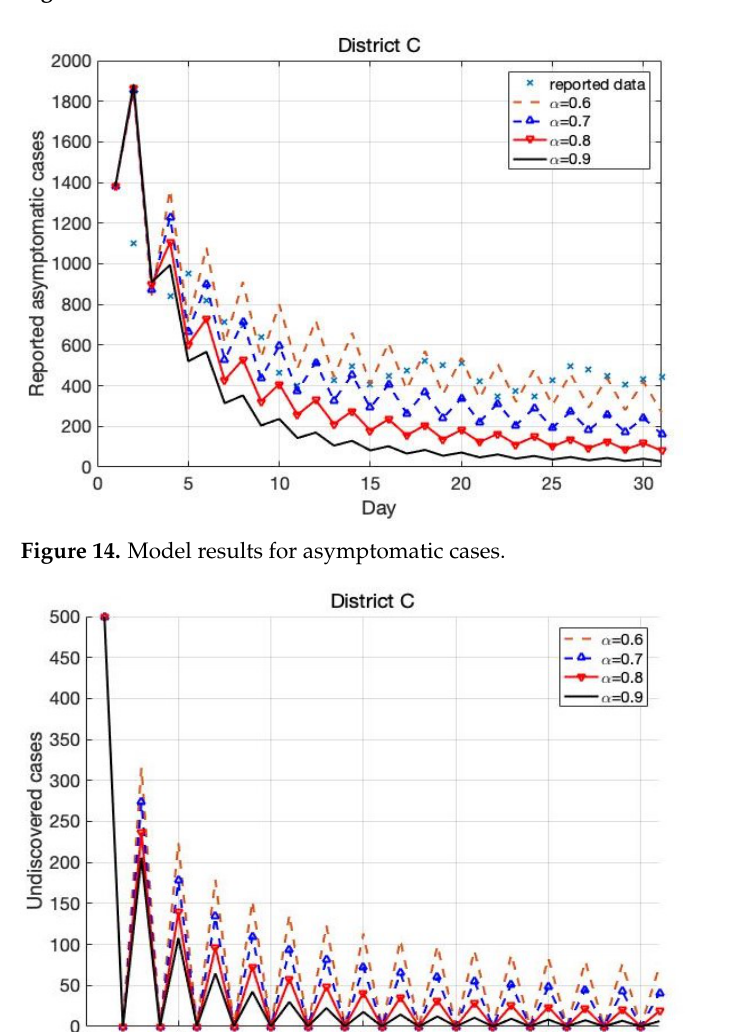
Figure 13. Model results for infected cases.